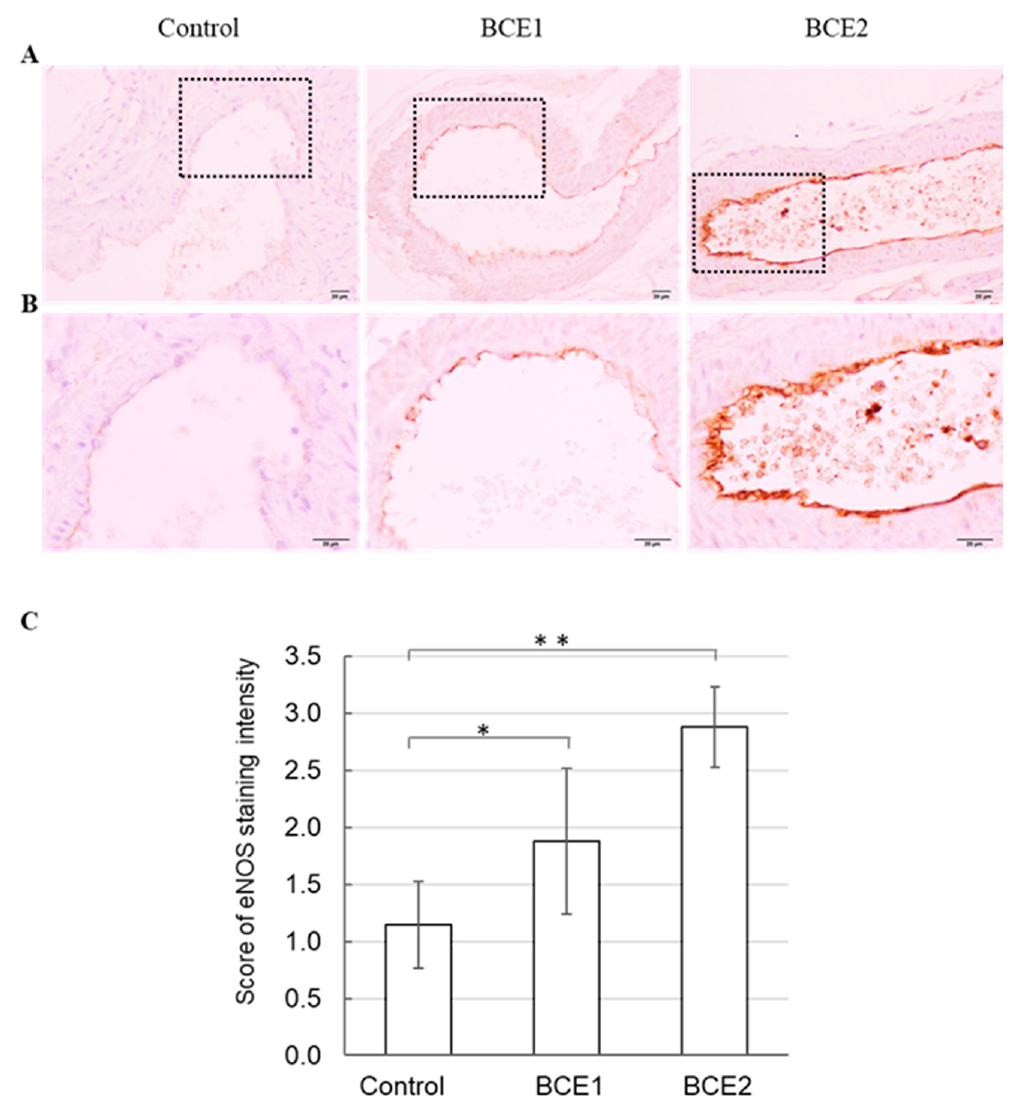
Figure 2. Immunohistochemical staining of eNOS in the Control (high-fat diet without BCE), BCE1 (high-fat diet supplemented with 1% BCE powder), and BCE2 (high-fat diet supplemented with 3% BCE powder) groups. ( A ) eNOS expression at a lower magnification (200×, scale bar = 20 µm). ( B ) A higher magnification image of the boxed areas shown in panel A (400×, scale bar = 20 µm). ( C ) Scoring of staining intensity of eNOS. Data are expressed as the mean score ± standard error. * p < 0.05, ** p < 0.01.